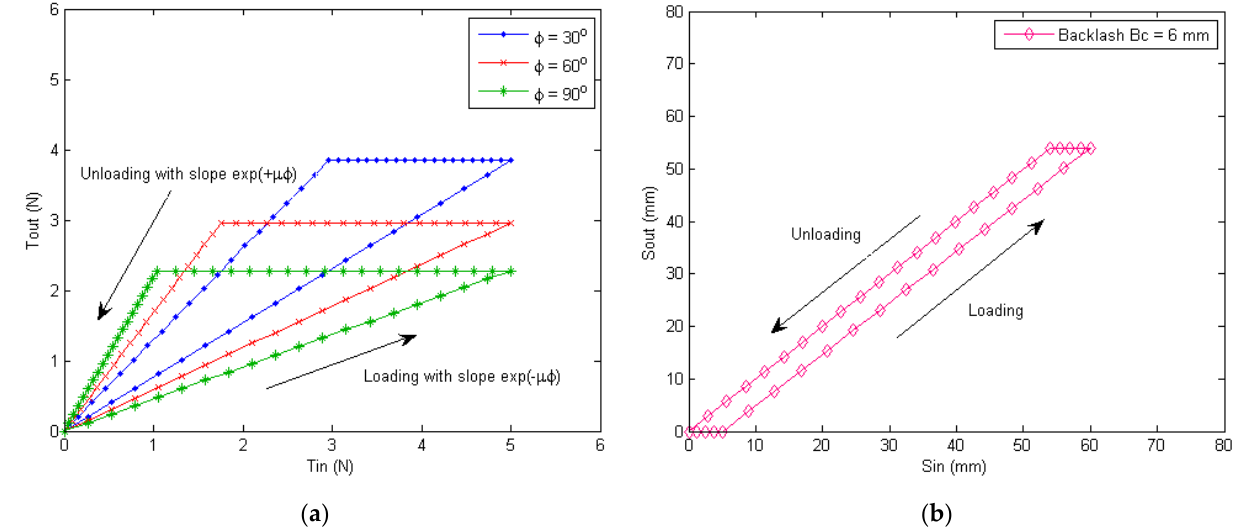
Figure 4. Loading and unloading curves for the Bowden cable friction and backlash. ( a ) Simulated relationship of the input and output tensions of the Bowden cable, for friction coefficient 𝜇 = 0.5 , at different bending angles 𝜙 . ( b ) Simulated relationship of the input and output displacements of the Bowden cable, with a cable backlash of 𝐵 𝑐 = 6 mm .